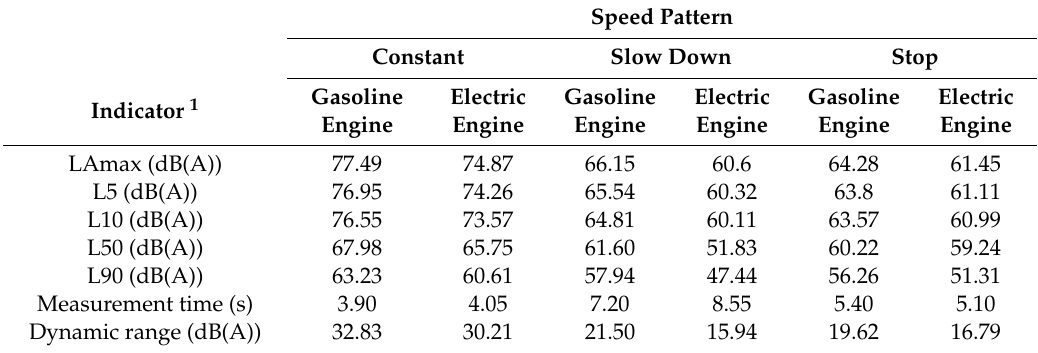
Table 3. Acoustic characteristics of the stimuli regarding the electric and gasoline combustion vehicles.